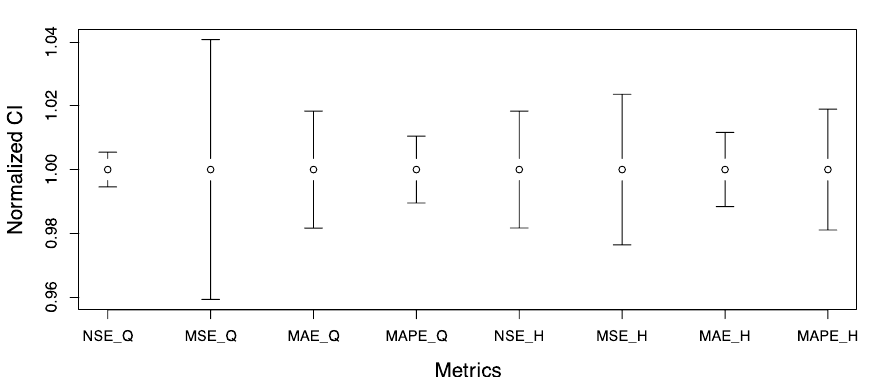
Figure 19. The uncertainty band of each metrics, calculated with the prediction made by Ensemble SSA GA and grouth truth